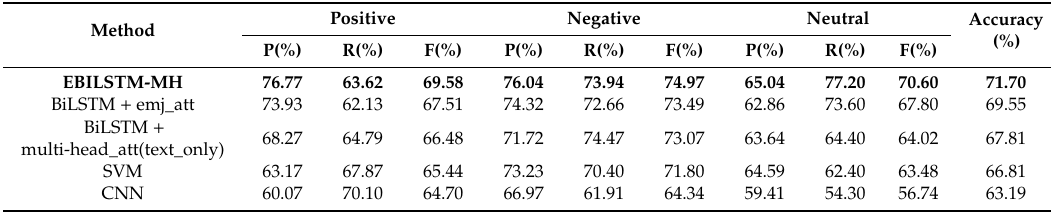
Table 7. The Result of proposed method and other